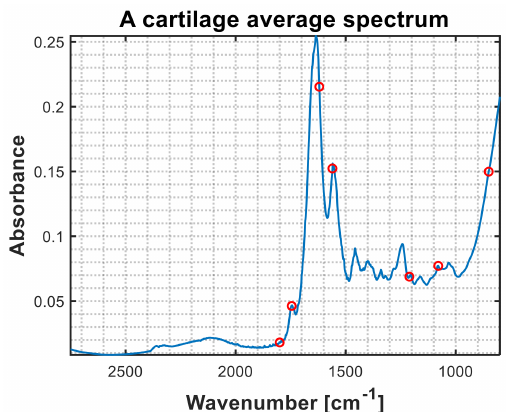
Figure 6. An average broadband spectrum of human cartilage obtained using dataset 2 in blue and the seven selected wavenumbers shown by red circles. The wavenumbers 1800, 1745, 1620, 1560, 1210, 1080, and 850 cm − 1 were selected based on their relevance to cartilage quality assessment and spectral